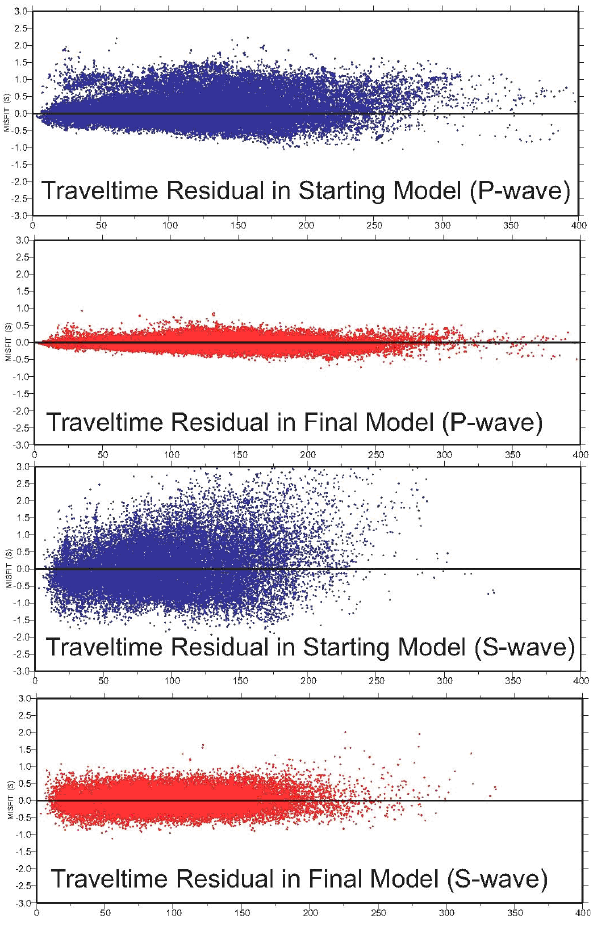
Fig. 2. P- and S-wave traveltime misfits in starting model and final